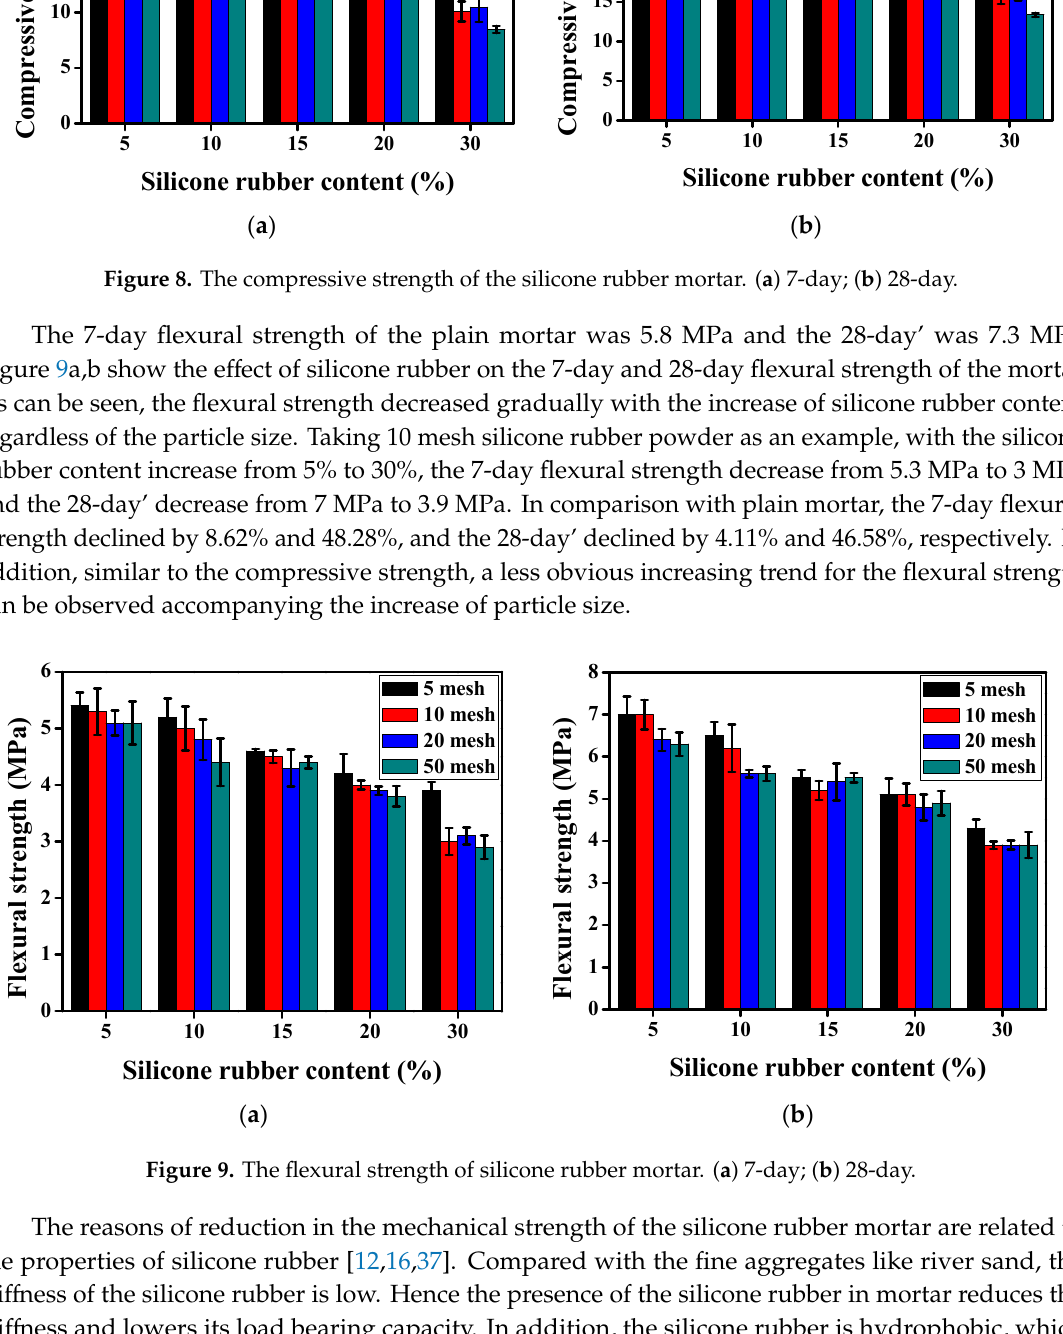
( c ) Figure 10. Failure modes of the mortar specimen in the compressive test, ( a ) plain ( b ) 5 mesh silicone rubber, 15% content, and ( c ) 5 mesh silicone rubber, 30% content. 3.2.2. Effect of the Modified Silicone Rubber on the Mechanical Strength of Mortar The effects of H 2 O 2 and KOH modified silicone rubbers on the 28-days mechanical strength of mortar are displayed in Figure 11. The silicone rubber treated by H 2 O 2 or KOH solution has an enhancing effect compared with the original silicone rubber, especially the compressive strength. For example, when the content of silicone rubber was 15%, compared with original rubber, the 28-days compressive strengths treated by H 2 O 2 and KOH improved by 10.56% and 12.44% respectively, and the 28-days flexural strengths improved by 1.82% and 7.27% respectively. The possible reasons for this effect are shown as follows. H 2 O 2 can remove the impurities on the surface of silicone rubber and improve its surface hydrophilicity, which ameliorates the interface between silicone rubber and cement paste, further increases the mechanical strength of mortar. Similarly, after treatment with KOH solution the hydrophilic property of the silicone rubber increases according to the contact angle result. In addition, the KOH can provide a weak alkali condition around the silicone rubber particles, which is conducive to the cement hydration around it,